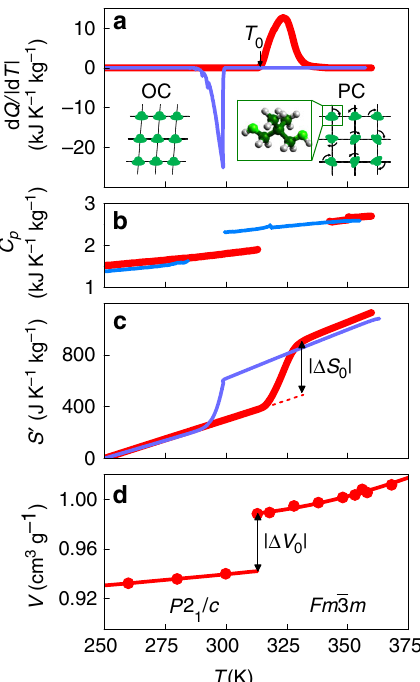
Fig. 1 Thermally driven phase transition in NPG at atmospheric pressure. a Measurements of d Q /|d T | after baseline subtraction, on heating (red) and cooling (blue) across the fi rst-order cubic-monoclinic phase transition, revealing a large latent heat. The insets represent simpli fi ed plan views of the globular (CH 3 ) 2 C(CH 2 OH) 2 molecules (C = dark green spheres, H = grey spheres and O = light green spheres), which are con fi gurationally ordered in the monoclinic ordered-crystal (OC) phase (left inset), and con fi gurationally disordered in the cubic plastic-crystal (PC) phase (right inset). We assume only one molecule per unit cell for ease of representation. b Speci fi c heat C p either side of the transition on heating (red) and cooling (blue). c Entropy S ′ ( T ) = S ( T ) − S (250 K ), evaluated via (cid:2) (cid:3) R T S ′ ð T Þ ¼ S ð T Þ (cid:2) S ð 250 K Þ ¼ = T ′ d T ′ , revealing a large C þ d Q = d T ′ j j p 250 K entropy change | Δ S 0 | for the transition. d Speci fi c volume V ( T ) on heating, revealing a large volume change | Δ V 0 | for the transition. Symbols represent experimental data, lines are guides to the